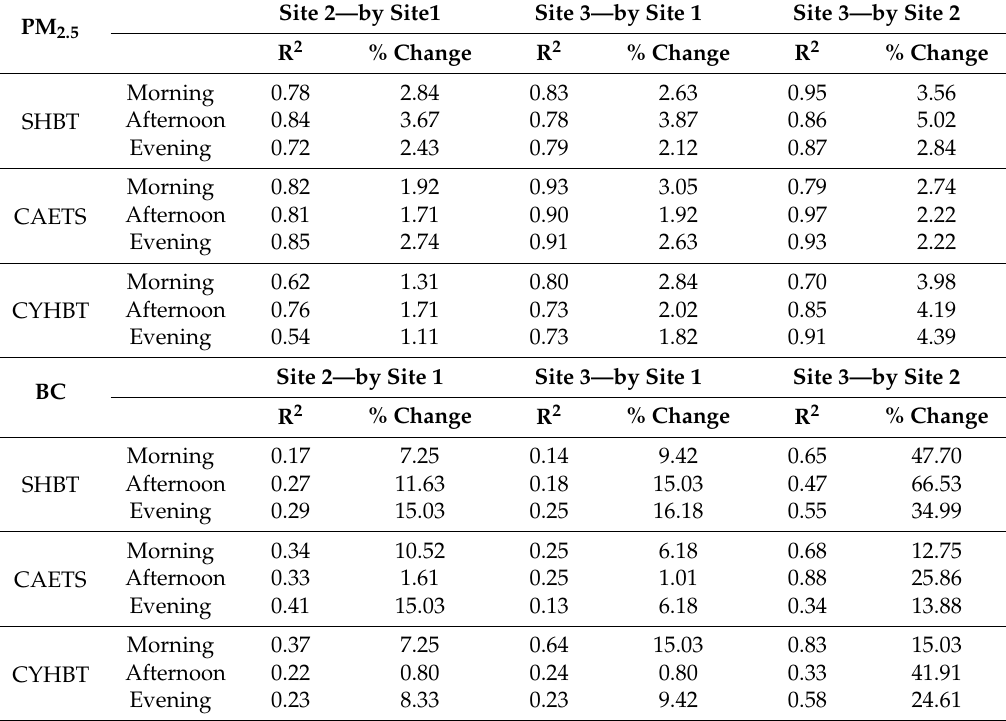
Table 2. Impact of unit increase of PM 2.5 (Top) or BC (Bottom) concentrations of Site 1 on Site 2 or Site 3 for morning rush hour, lunch time, or evening rush hour. All of the values of % changes were statistically significantly different from 0 at the significant level of 0.05. A positive value suggested that % increase of BC or PM 2.5 concentration at Site 2 or 3 by unit ( µ g/m 3 ) increase of BC or PM 2.5 concentration at Site 1, respectively. PM